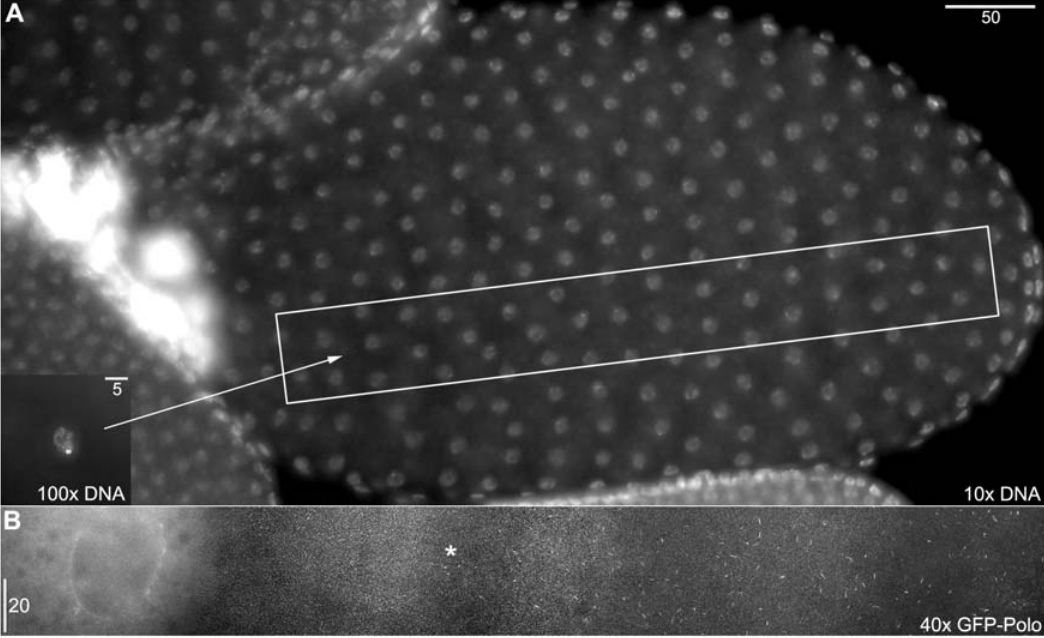
Figure 1. GFP-Polo Oocyte fixed in mid-NEB with nascent filament formation. 1A. An image of a late stage 12 or early stage 13 GFP-Polo oocyte, which was presumably fixed in the early stages of nuclear envelope breakdown (NEB), with the anterior end of the oocyte on the left and the posterior end on the right. While this image is of a fixed sample and it is therefore impossible to be certain that this oocyte is undergoing NEB, the characteristics of the cell (the shape of the karyosome (inset), the growth of the dorsal appendages, and the appearance of the nuclear envelope) are all similar to those of oocytes that were imaged going through NEB. The GFP-Polo filaments cannot be seen at this magnification. 1B. A composite of five individual image stacks, showing the GFP-Polo localization of the region inside the rectangle in 1A. Note the GFP-Polo localization to the nuclear envelope on the left. The filaments become shorter and less abundant moving across the oocyte from posterior to anterior, with the location of the last resolvable filaments indicated (asterisk). This pattern is consistent with the linear polymerization of filaments occurring at NEB, with filaments growing linearly from ‘‘seeds’’ and polymerization being triggered by a wave that propagates across the oocyte from posterior to anterior.